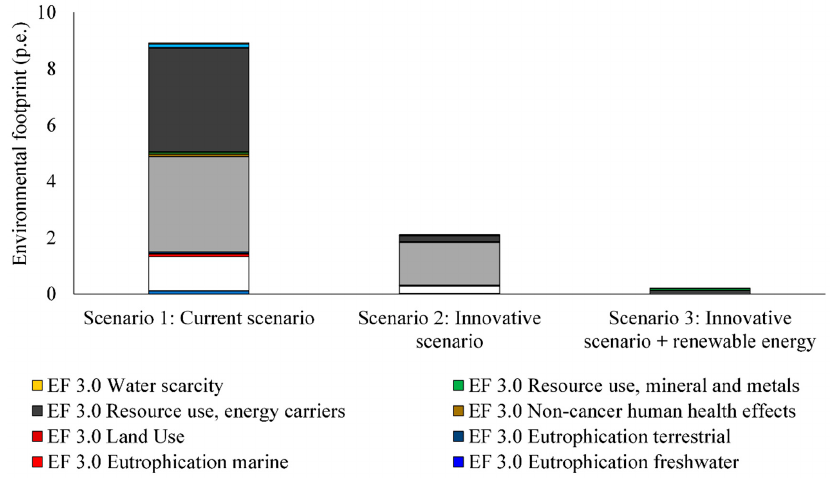
Figure 4. Results of LCA: environmental footprint, expressed as person equivalent (p.e.). Functional unit: 10 tons of wood products.